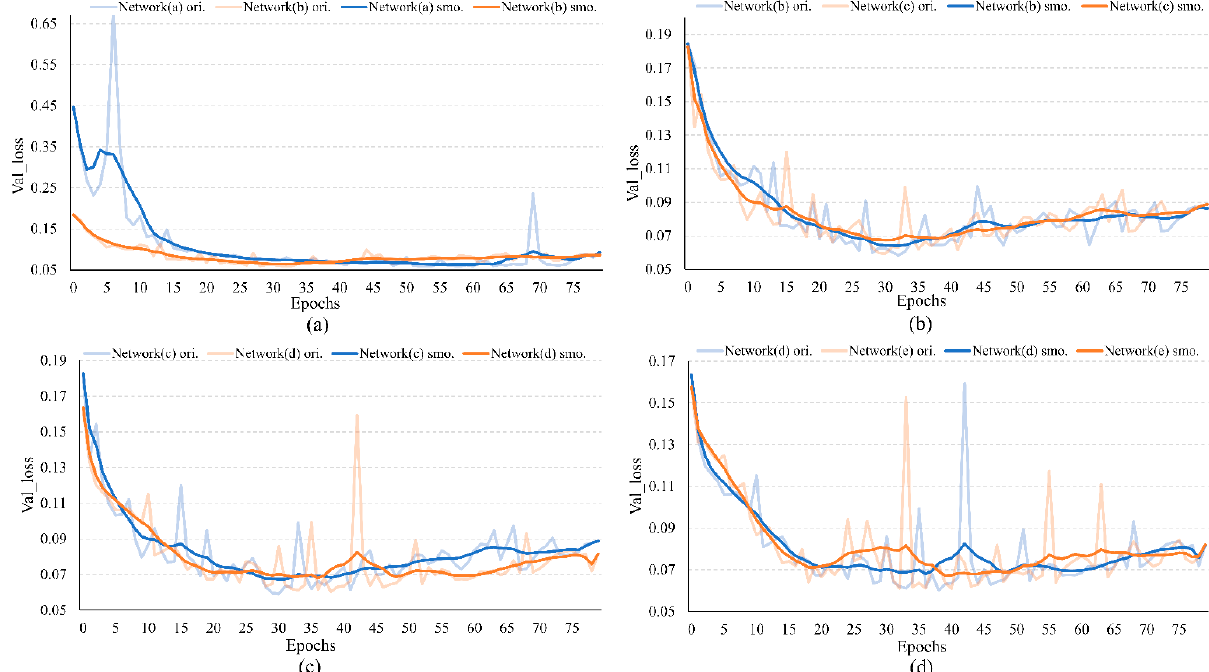
Figure 7. The loss curves over the validation subset for ablation networks. ( a ) The ablation comparison of MFF. ( b ) The ablation comparison of DS. ( c ) The ablation comparison of FF. ( d ) The ablation comparison of CL. The initial loss value is shown by the light-colored line in the figures. To better show the comparison, the original (ori.) loss curves were processed by the smoothing (smo.) function and formed more smooth dark curves. The results of the experiments showed that the MFF and CDSFF were favorable for obtaining accurate detection outcomes and for guiding the network to a stable and rapid gradient descent. However, when these modules were replaced or removed, the capacity of the network to extract the features was harmed. In a word, CSD-Net with MFF and CDSFF gained the best performance.